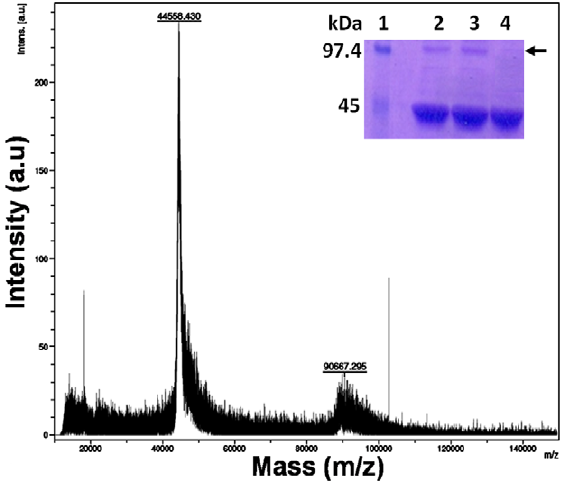
Figure 6. Oligomeric state determination. MALDI-TOF MS analysis of Eh ODC showing two peaks corresponding to , 44558.430 Da and , 90667.295 Da. The insert shows 12% SDS-PAGE analysis of glutaral- dehyde crosslinked Eh ODC. Lane 1: Molecular weight markers; Lane 2–3: Protein treated with glutaraldehyde and the two bands correspond to dimer ( , 90 kDa) and monomer ( , 46 kDa). Arrow points to the crosslinked dimer of Eh ODC; Lane 4: Purified protein not treated with glutaraldehyde.